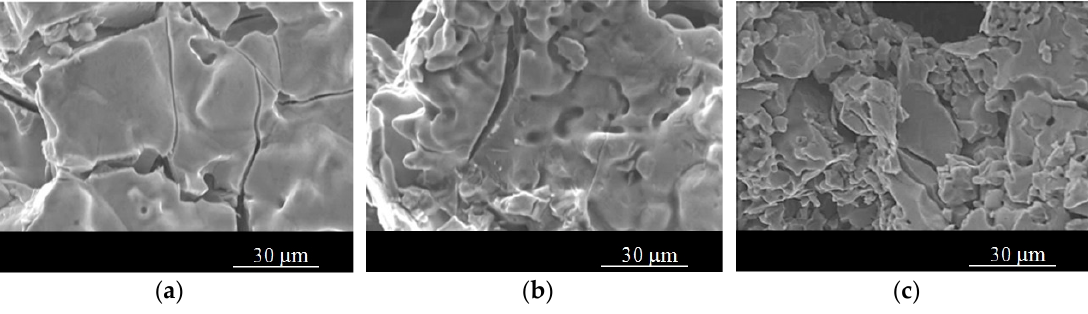
Figure 10. SEM images of compressed porous Ti samples with different porosities at ×1000 magnification; ( a ) 57.6%, ( b ) 69.7%, and ( c ) 78.0%.